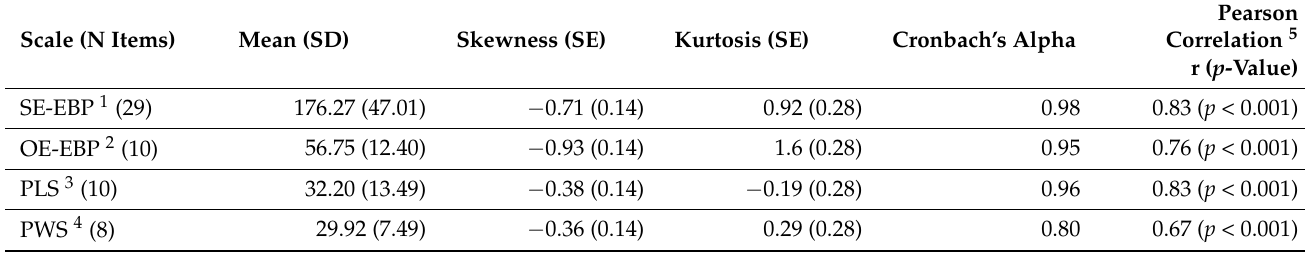
Table 1. Distribution characteristics and internal